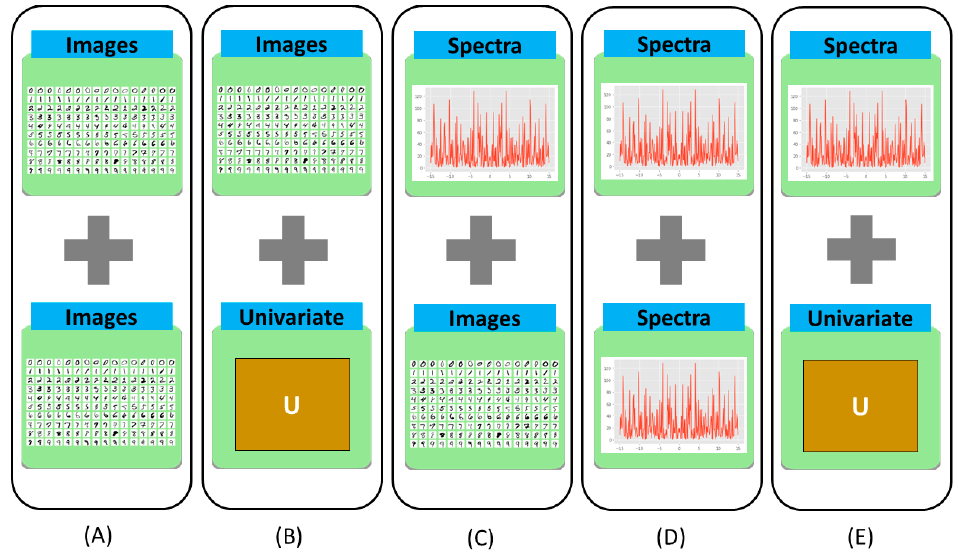
Figure 4. ( A ) Combination of image to image [Here, Image from MNIST [34] dataset]. ( B ) Combination of image to biomarker. ( C ) Combination of spectra to image. ( D ) Combinations of spectra to spectra. ( E ) Combination of spectra to biomarker .